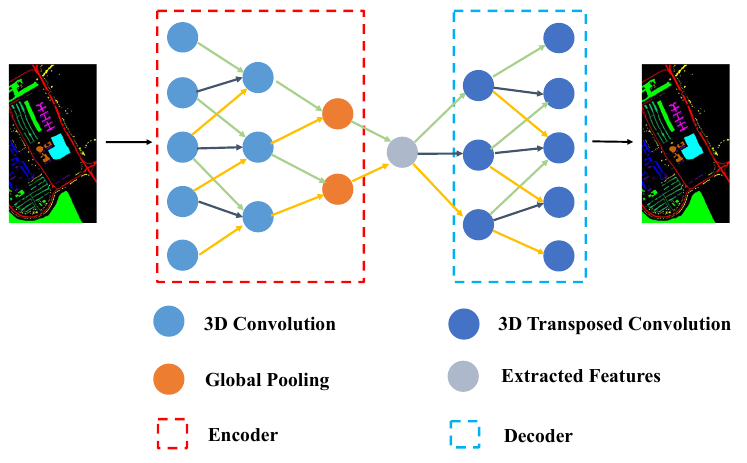
Figure 1. Structure of the 3D-CAE